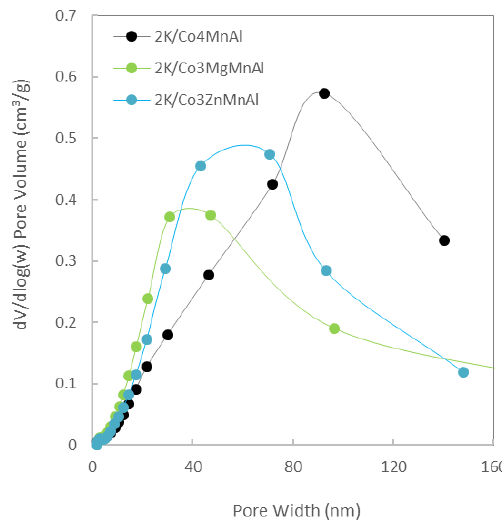
Figure 1. Pore size distribution evaluated from the physical adsorption of nitrogen.